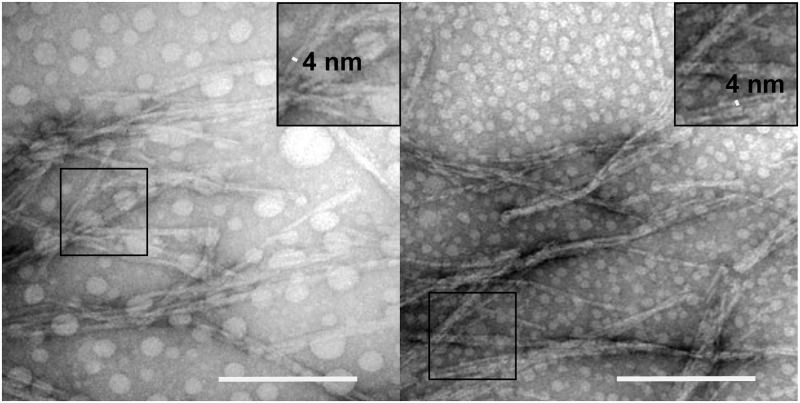
Negatively stained TEM images of co-fibrils with a molar ratio of chimeric over carrier protein equal to 3x10-3:1 (left) and 30x10-3:1 (right).The width of the single fibril in the frequently observed parallel bundles is 4 nm. A representative part of the images has been enlarged to highlight a single fibril. The scale bars indicate 200 nm.